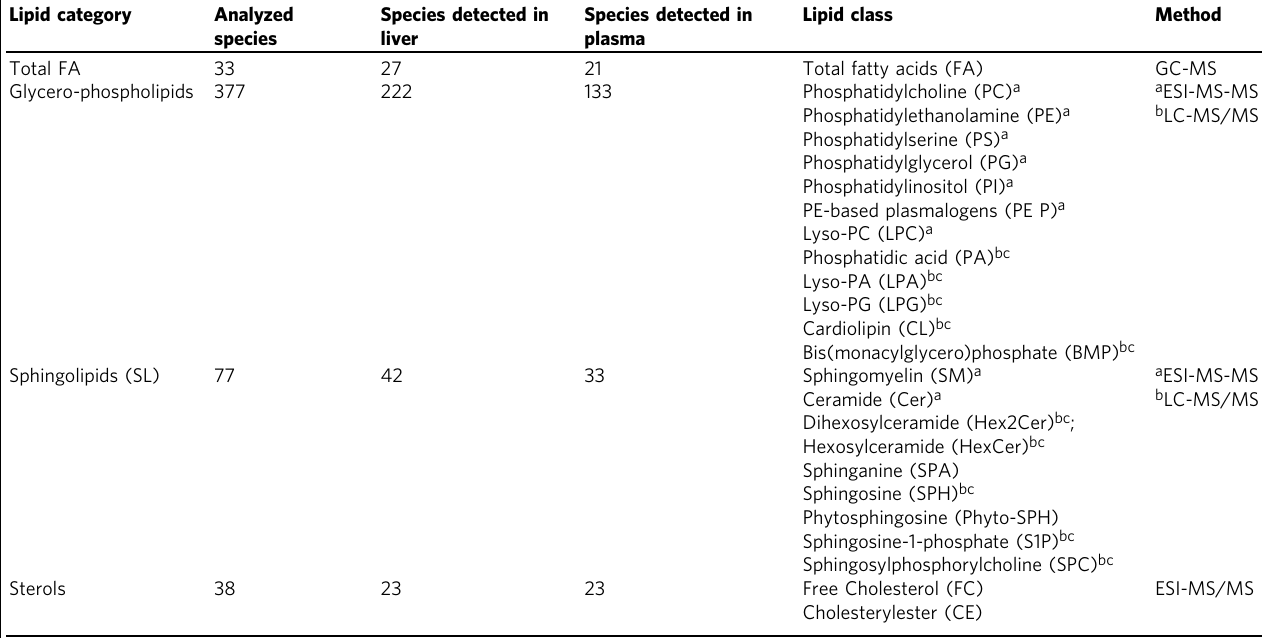
Table 1 Summary of lipids quanti fi ed in plasma and liver samples from GF and SPF animals using mass-spec – based methods Lipid